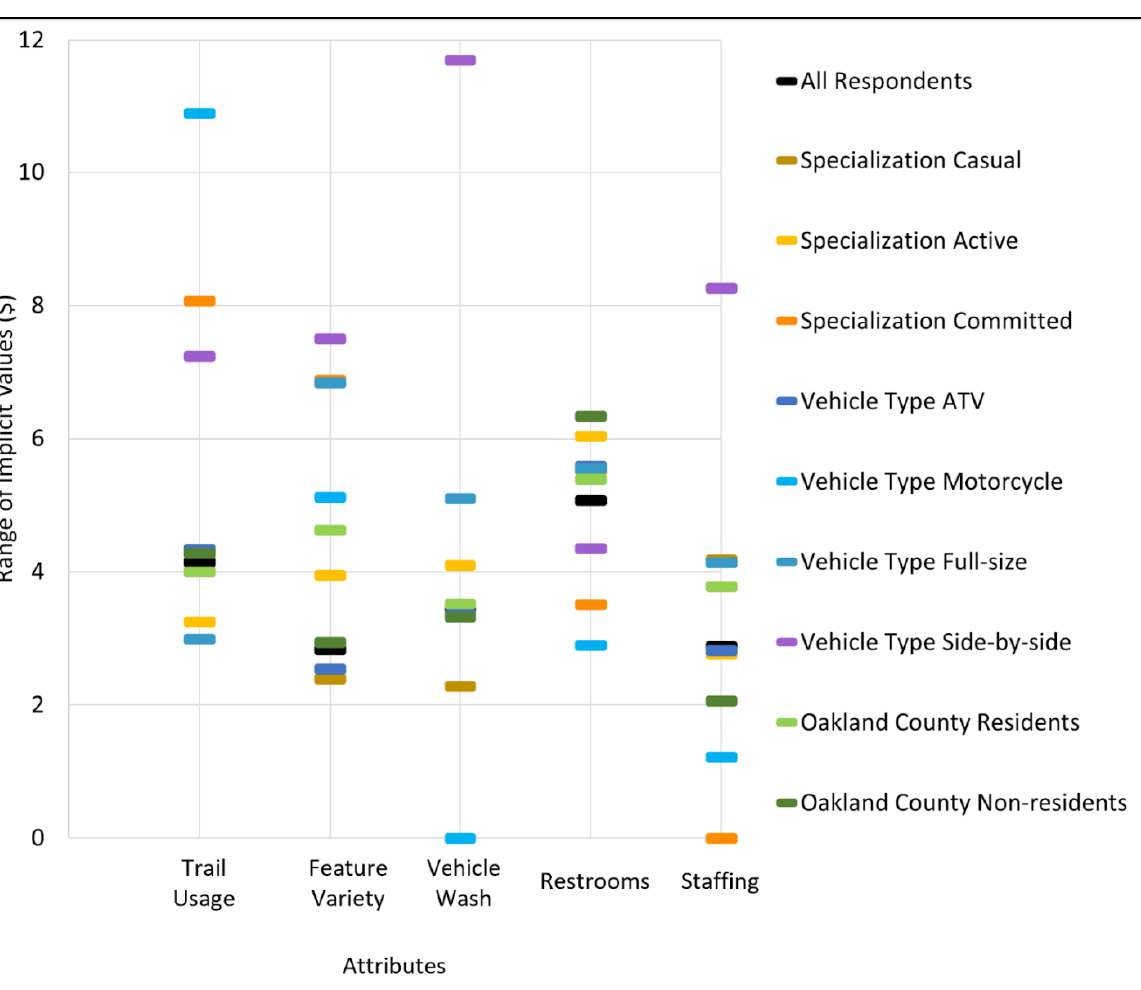
Figure 5. Ranges of implicit values between the lowest and highest level of each attribute for all respondents and by specialization categories, vehicle types, and Oakland County residency. Specific values for the ranges plotted are listed in the preceding tables.